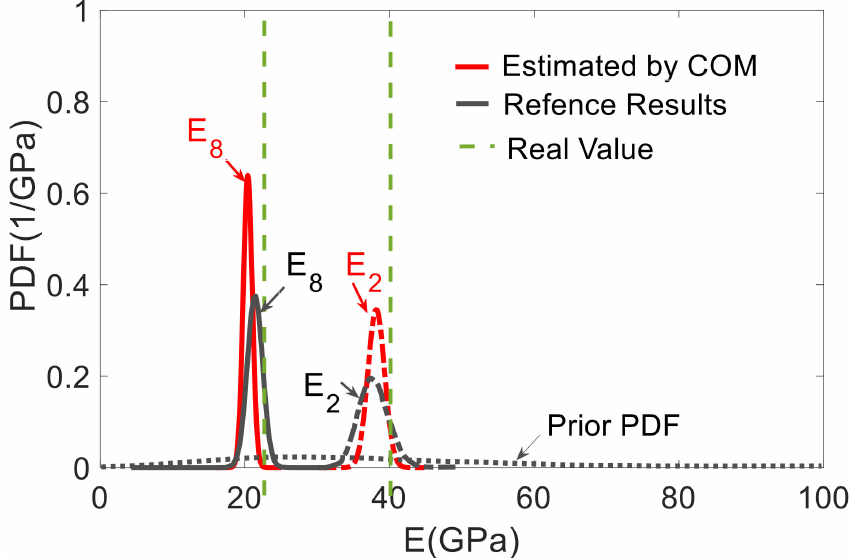
Figure 16. Uncertainty distribution of Young’s modulus E 2 and E 8 , prior and posterior PDF (grey line) of element Young’s modulus according to [4], the red PDF by COM UQ